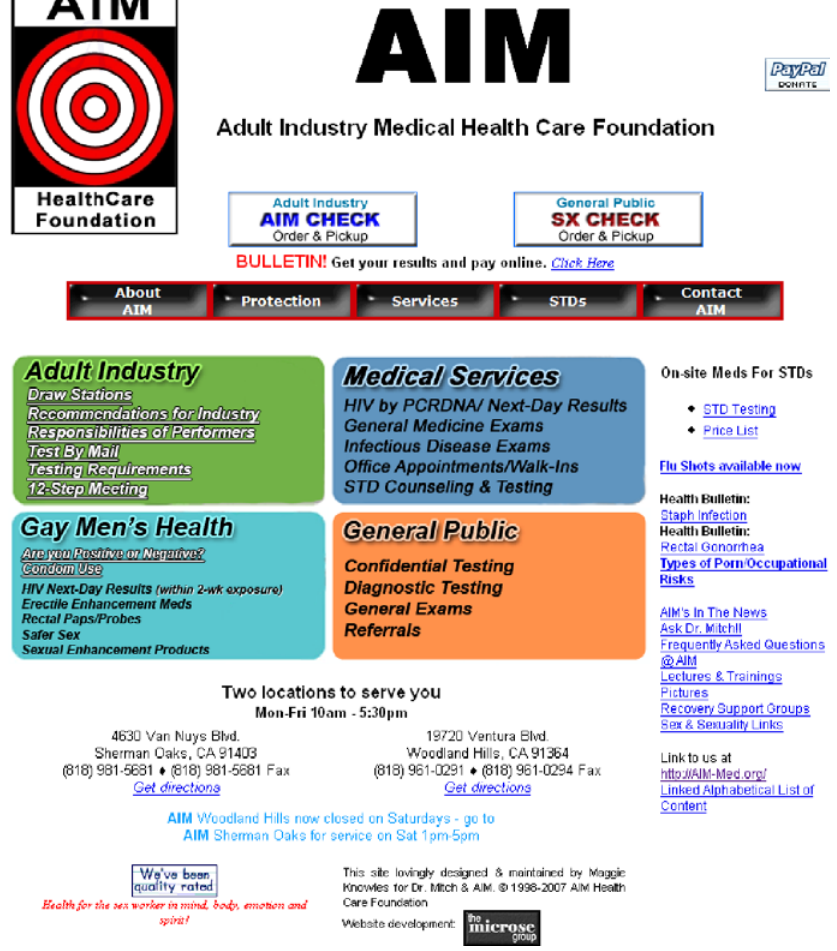
Figure 1. Screenshot of the Web site of Adult Industry Medical Health Care